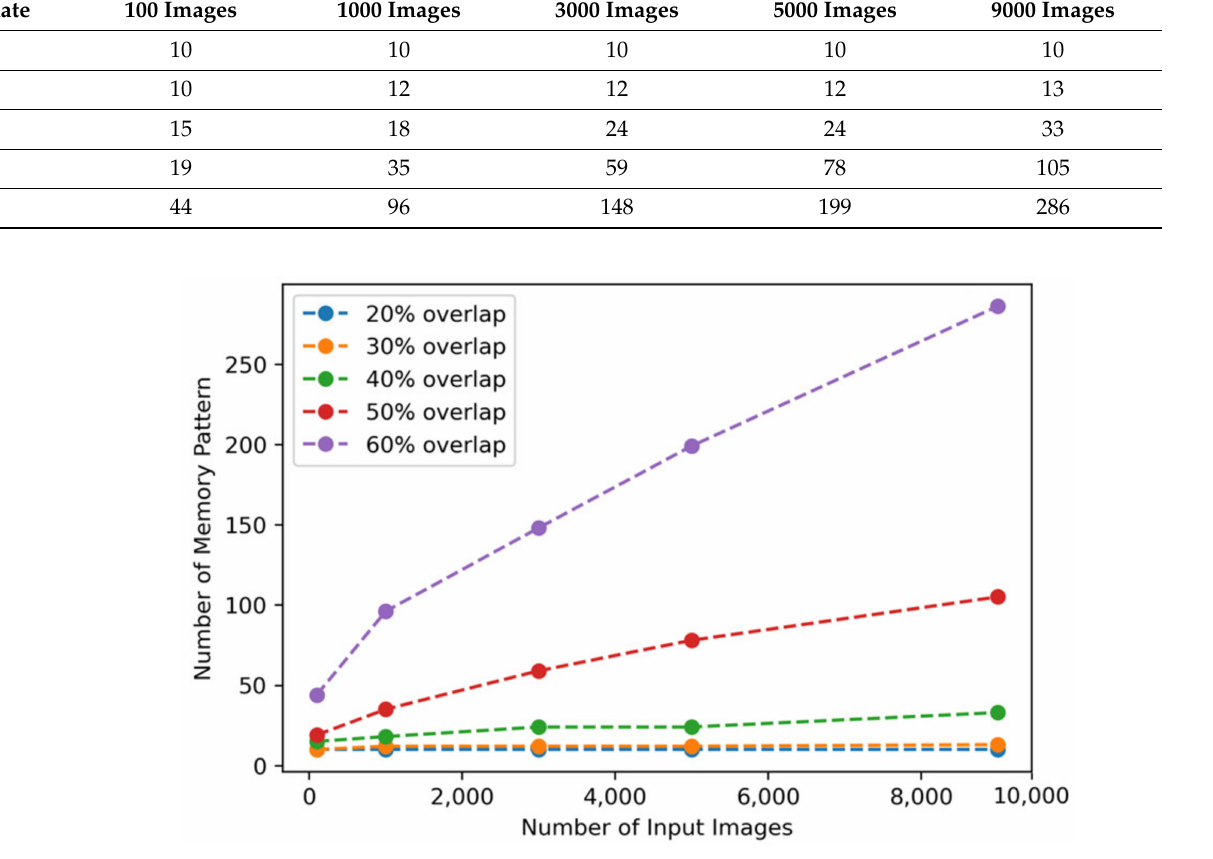
Figure 20. Number of memory patterns according to SDR overlapping ratio and number of input images with pre-memory